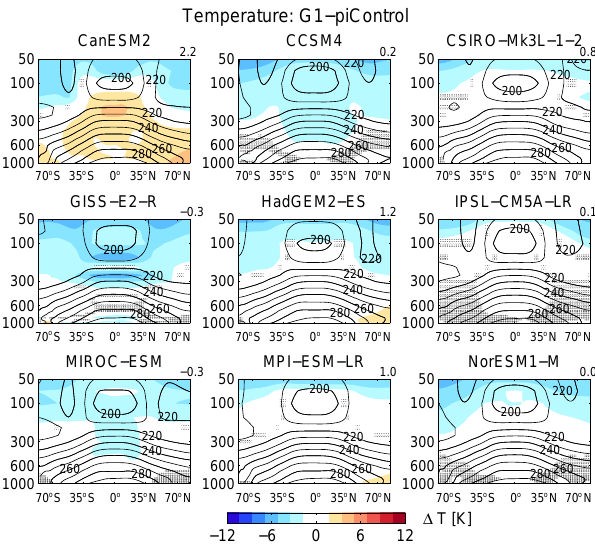
Figure 3. The difference in the zonal-mean temperature between the G1 and piControl experiments for each of the nine models. The G1 experiment temperature minus the piControl experiment tempera- ture is shown in shading (Kelvin), while the piControl experiment temperature is shown by the black contours (Kelvin). Stippling in- dicates differences not significant at the 95% confidence level. The change in global-mean surface temperature (Kelvin) between the G1 and piControl experiments is shown in the upper right of each